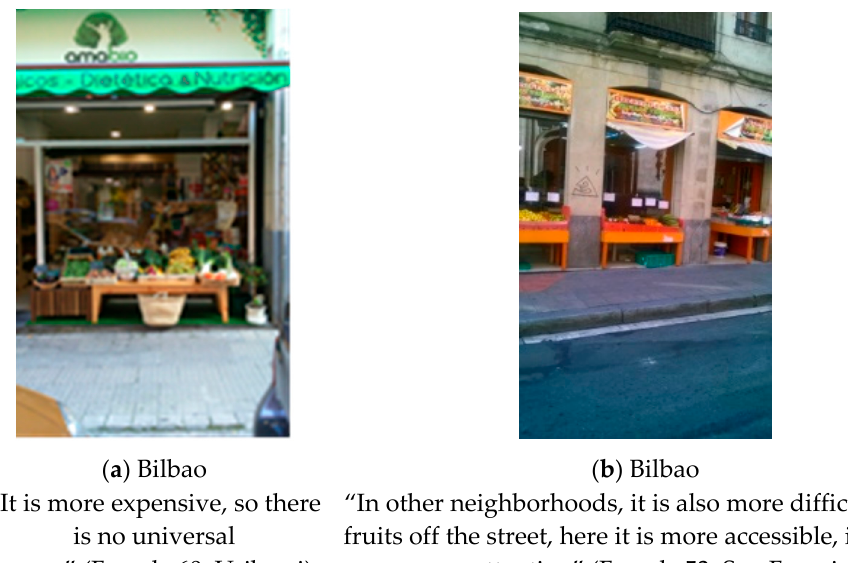
Figure 6. ( a ) Photograph made in Bilbao: “Ecological store”. Category: Original food recovery. Theme: Healthy eating habits; ( b ) Photograph made in Bilbao: “Fresh vegetables”. Category: Restaurants for the neighborhood. Theme: Healthy eating habits.